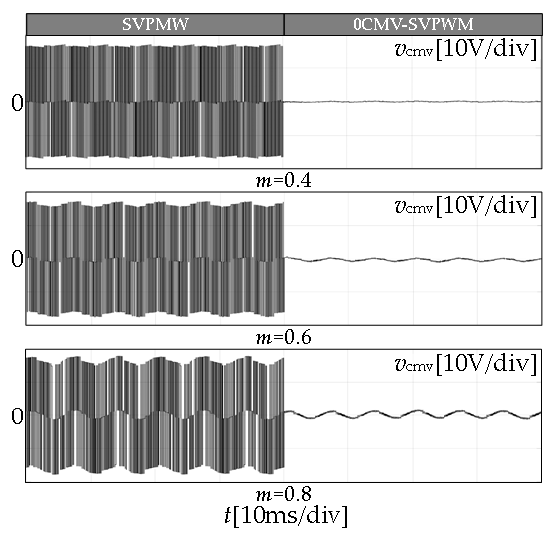
Figure 13. The effect of dead time on output.